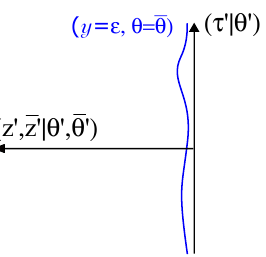
Figure 1 . Regularized holographic boundary at proper location (2.64). The actual shape